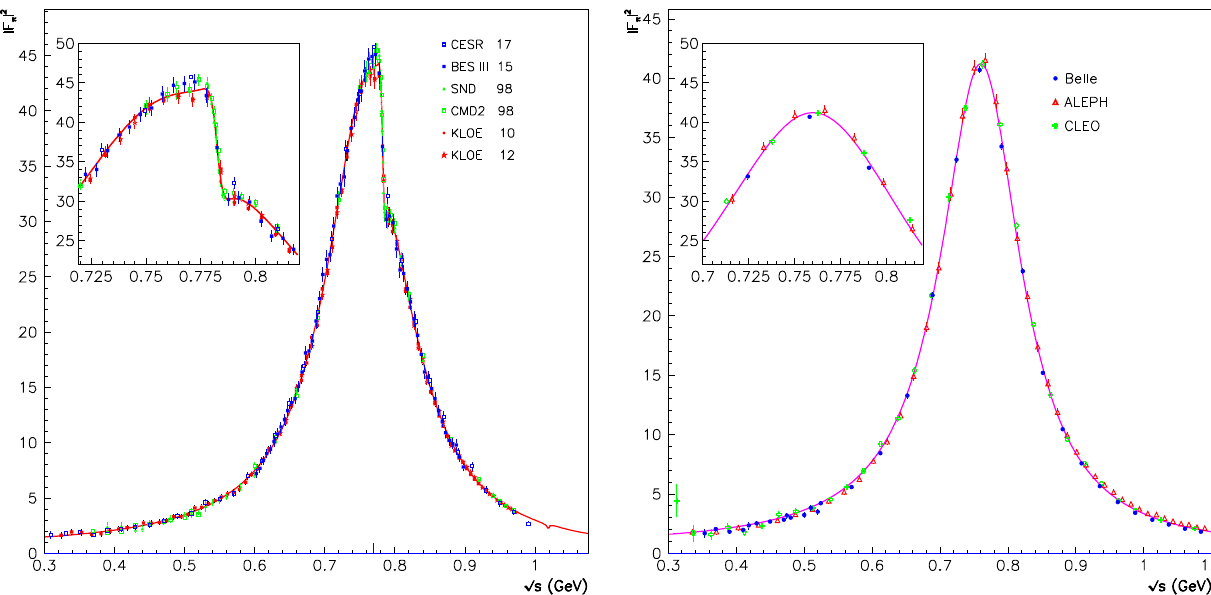
Fig. 2 BHLS 2 fit to the ππ data, the RS solution: the leftmost panel shows the pion form factor squared in the e + e − annihilation and the rightmost one displays the same spectrum in the τ decay. The fitted regions extend up to s = 1 . 0GeV 2 Fig. 3 BHLS 2 fit to the π + π − π 0 spectra, the RS solution: top panels show the fit and data in, resp. the ω and φ regions, the bottom one focuses on the intermediate